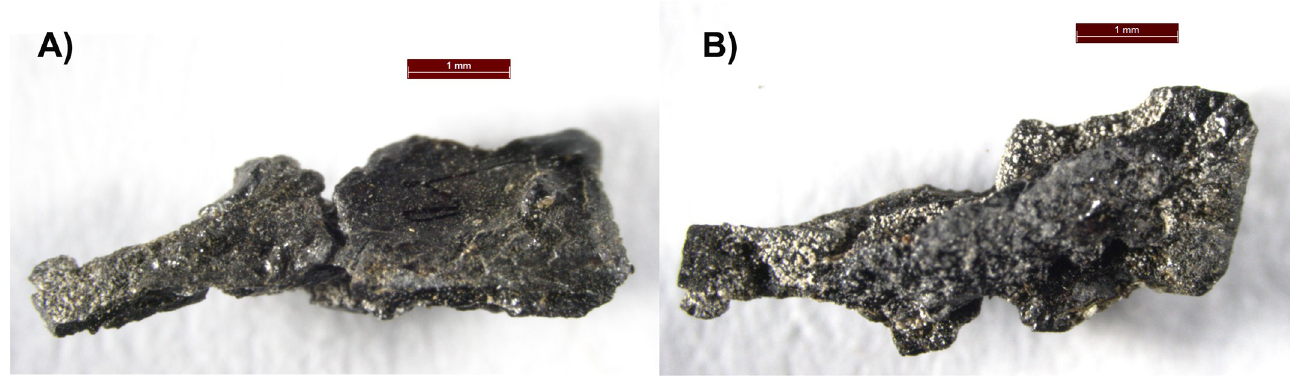
Fig 7. Optical microscope photos of the sample OM S7 from the left foot toe area showing the white particles (sodium salts) under the embalming resin sample. A—upper part, and B—lower part of the sample piece.